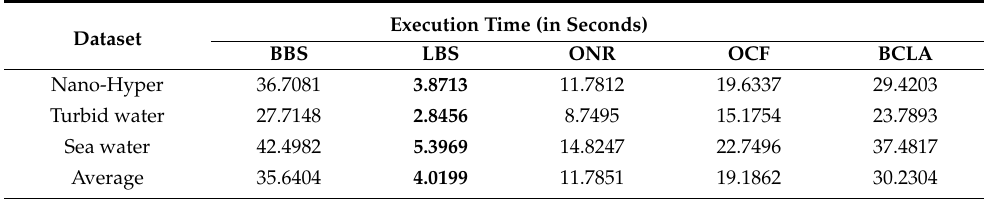
The bold entries represent the best performance in each